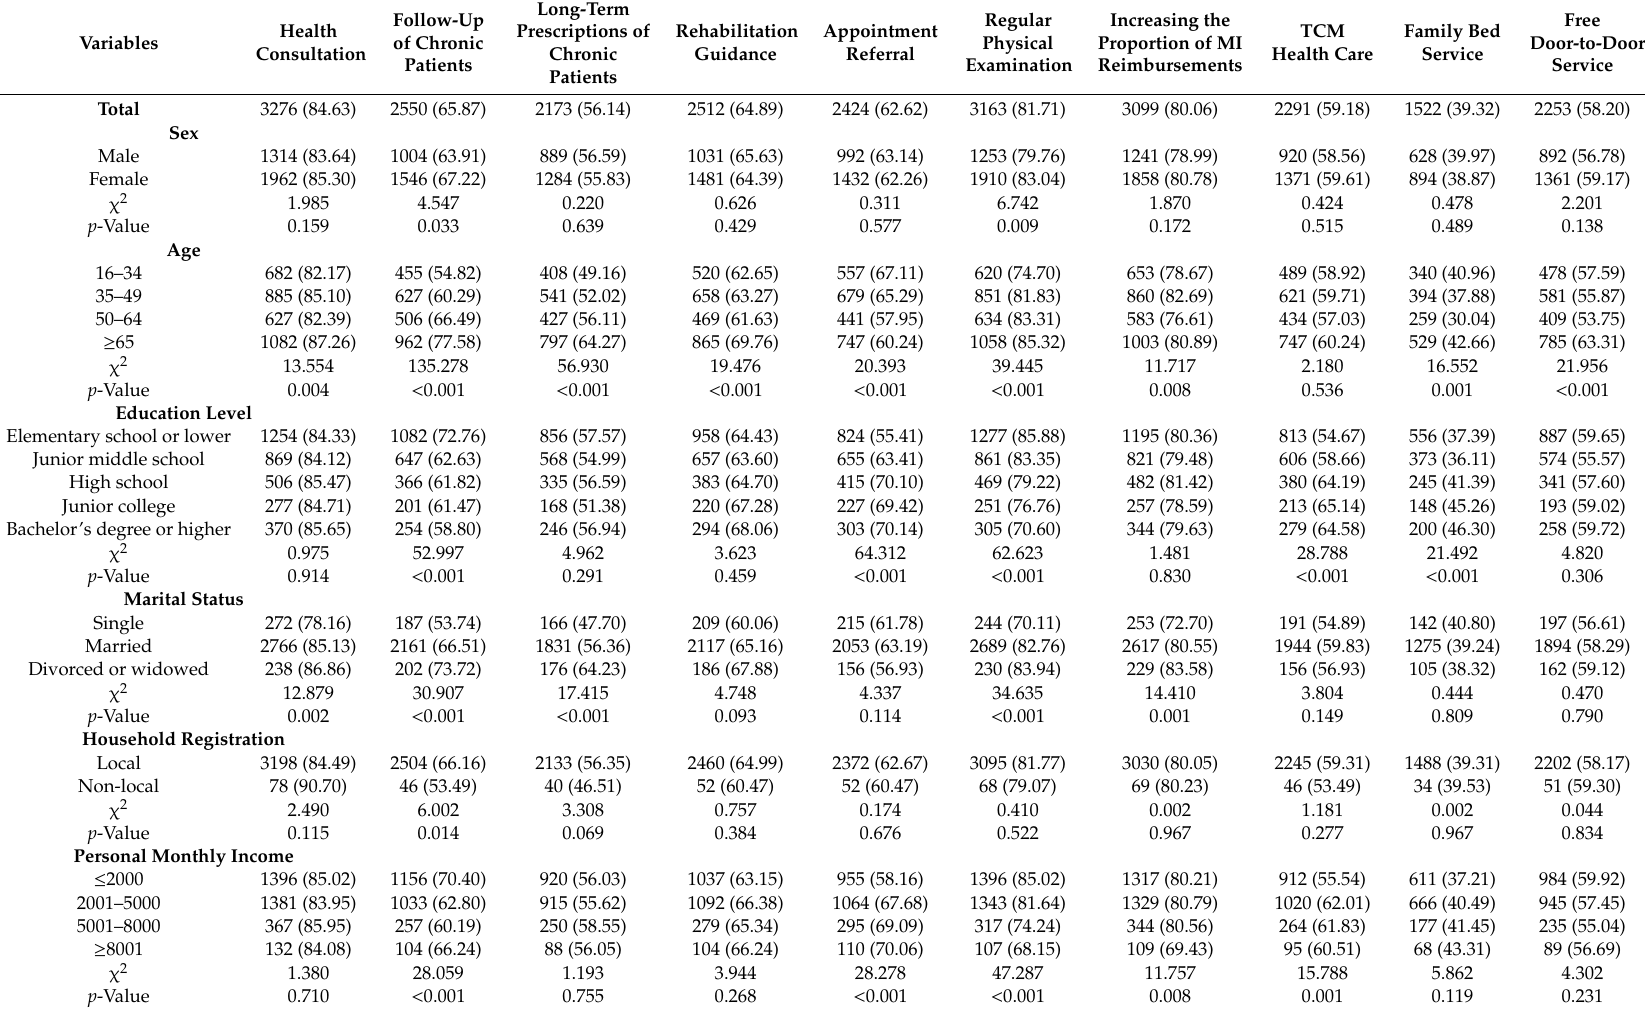
Table 4. Comparison of FDCS demands among di ff erent residents ( n = 3871) N